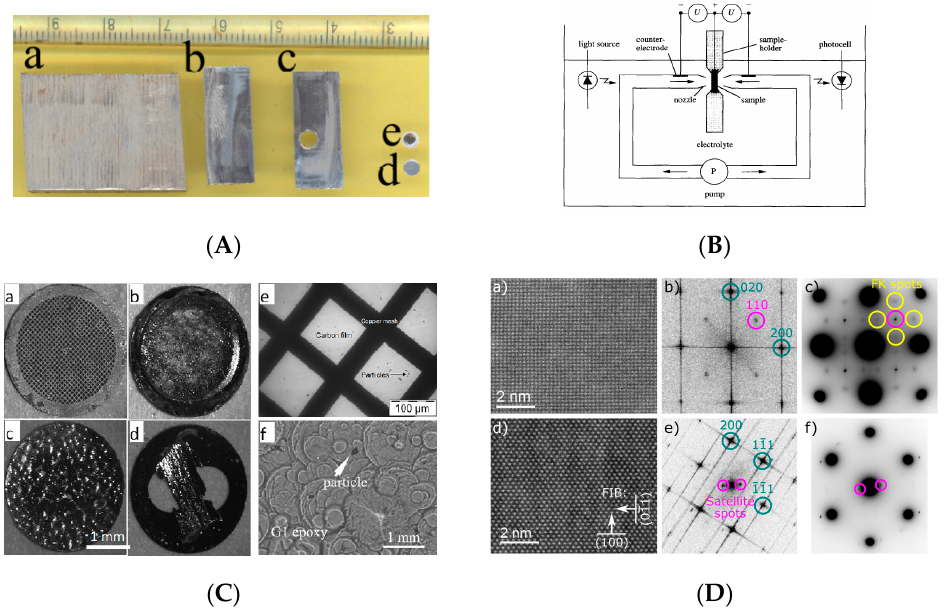
Figure 25. ( A ) Optical images of ( a ) sample, ( b ) slice sectioned from the sample using low-speed diamond saw (isomet), ( c ) slice after punching TEM disc ( d ) TEM disc ( e ) TEM disc after grinding and electropolishing (note the shiny contrast in the central portion due to electropolishing [59] (copyrights granted by author). ( B ) Schematic of twin jet electropolishing, (copyrights granted by Elsevier) [163] ( C ) Nano-structure based optical images of TEM samples in various forms is shown, ( a ) carbon coated, ( b ) mechanically milled, ( c ) free standing ribbon processed by rapid solidification, ( d ) small ribbon bonded to a slotted copper grid, ( e ) TEM image showing the powder particles on copper grid, ( f ) optical image of iron powder particles embedded in epoxy [59] (copyrights granted by author), ( D ) TEM results showing grain orientation of electropolished Al samples at 200 kV electrons, ( a , d ) cut-outs from larger ADF-STEM images in [001] and [011], ( b , e ) Fourier transforms, ( c , f ) diffraction patterns of ( a , d ) [29], (open access article distributed under the terms of the Creative Commons CC-BY license).